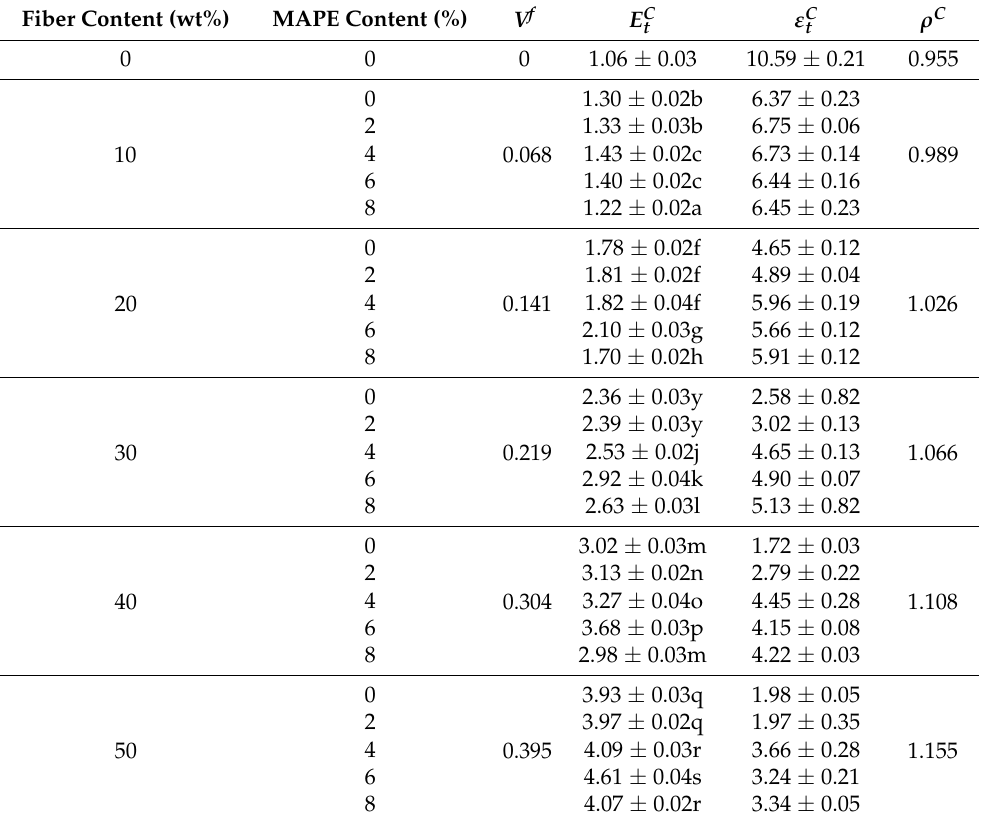
Table 1. Experimental results of bio-polyethylene composites with different fiber content and different coupling agent dosage. Means followed by the same letter are not a significant difference at the 0.05 probability